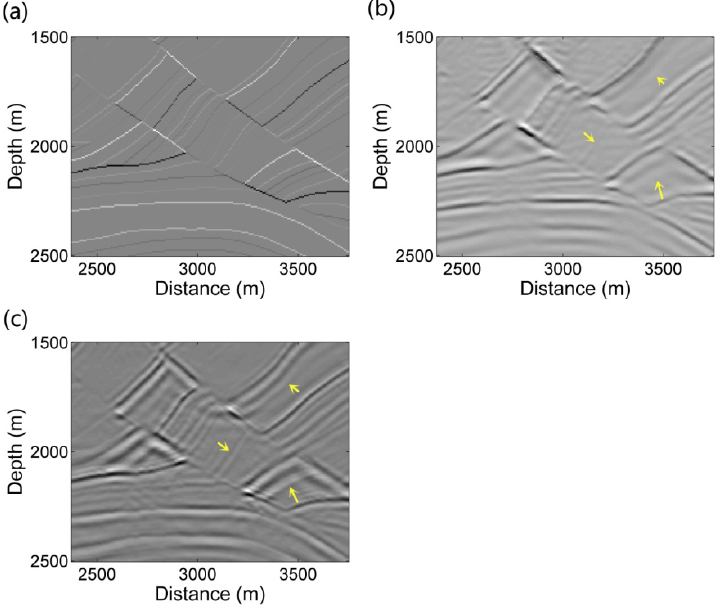
Figure 6. ( a ) The theoretical reflection coefficient; ( b ) The imaging result of RTM; ( c ) The imaging result of our proposed method.